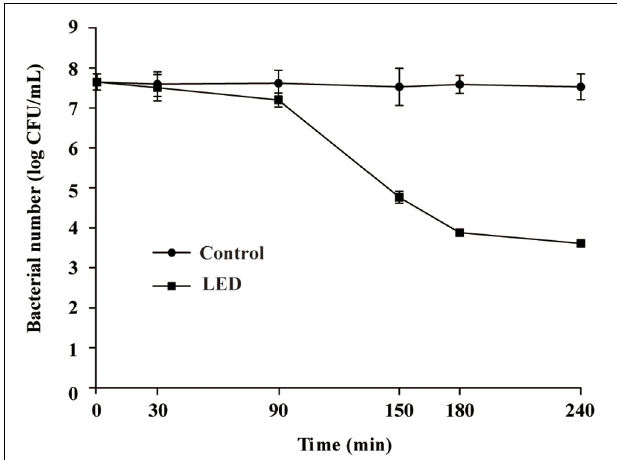
FIGURE 1 | Effect of 405-nm LED illumination on the survival of L. monocytogenes suspensions at 4 ◦ C.